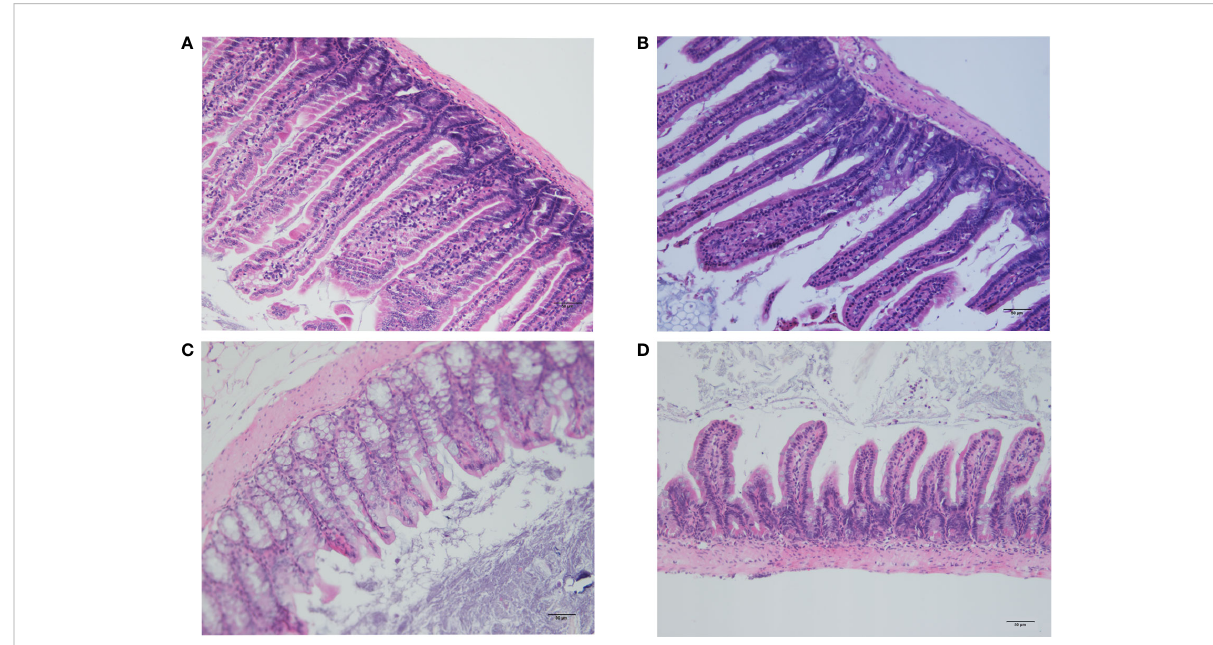
FIGURE 7 Histological examination of the small intestine and colon. (A) Histological analysis of the small intestine in the sham group. The intestinal mucosal villi were unchanged and normal. (B) Histological analysis of the small intestine in the CLP6h group. The intestinal mucosal villi were sparse and irregular, and the villi became short and broken, with reduced mucosal layer glands and in fi ltration of in fl ammatory cells in the muscularis in the CLP6h group. (C) Histological analysis of the colon in the sham group. The intestinal mucosal villi were unchanged and normal. (D) Histological analysis of the colon in the CLP6h group. The intestinal mucosal villi were sparse and irregular, and the villi became short and broken, with vacuolization at the top, reduced mucosal layer glands, and in fi ltration of in fl ammatory cells in the muscularis in the CLP6h